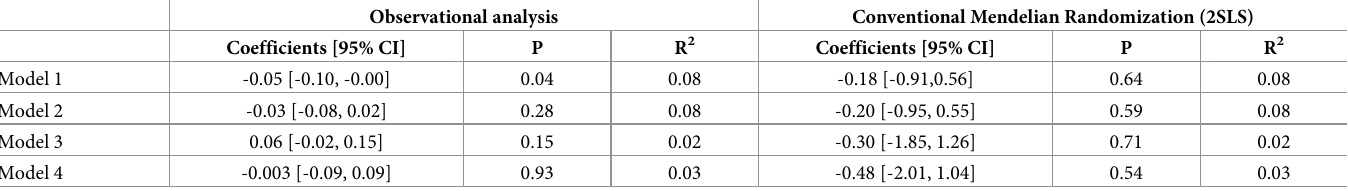
Table 3. Association between age at menarche (AAM) and young adulthood body mass index (BMI) using observational and conventional MR analysis, the Korean Genome and Epidemiology Study (KoGES) and Healthy Twin Study (HTS) (n = 4,093